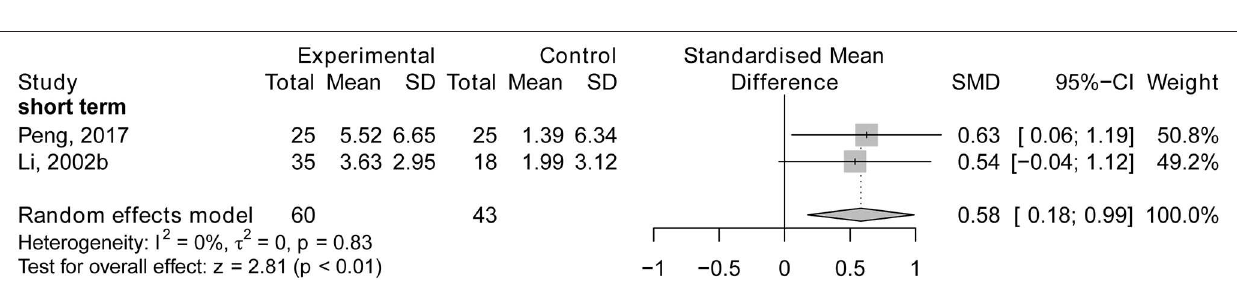
FIGURE 10 | The forest plot of HDS of acupuncture plus drug therapy vs. drug therapy alone. Li (2002b), acupuncture plus Dangguishaoyaosan vs. Dangguishaoyaosan.